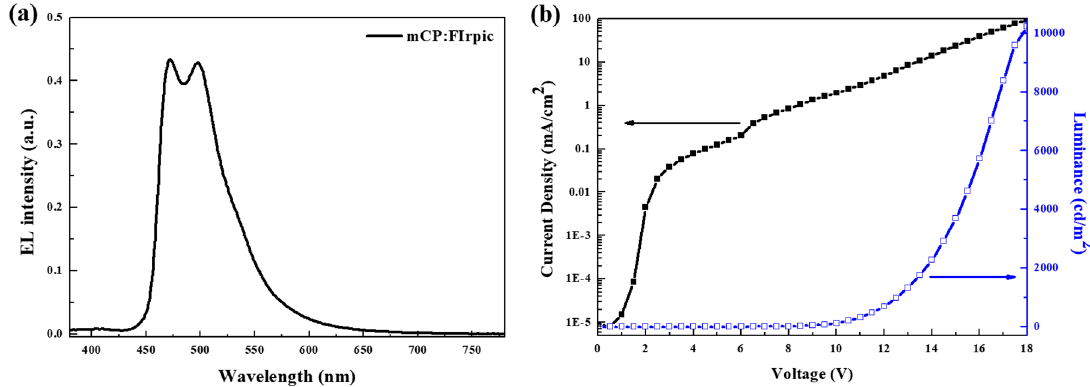
Figure 2. Electroluminescence ( EL) spectrum of hybrid QLEDs with double EMLs for an applied voltage of 10.5 V.